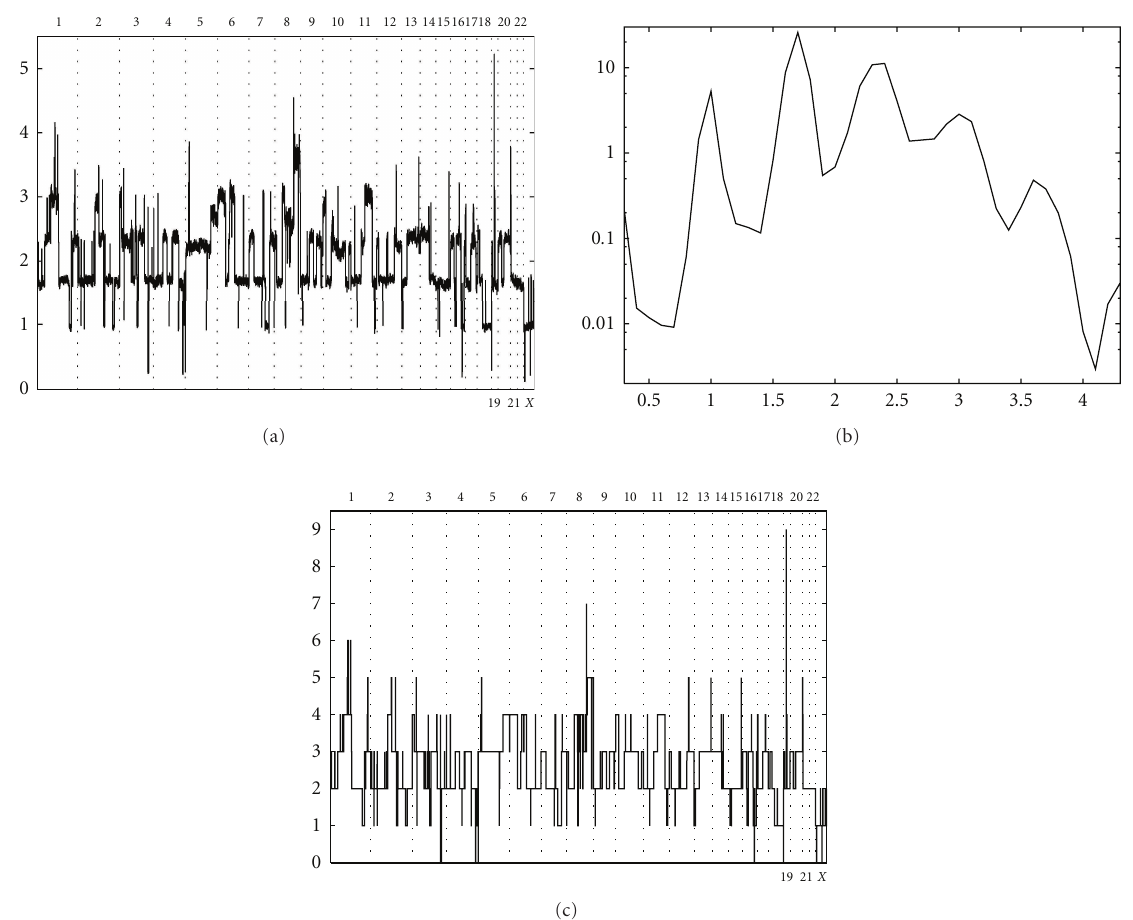
Figure 3: (a) Signal intensity of SNPs ( y axis) for ovarian cancer cell line OVCAR8 before adjustment on genome size. (b) Fraction of SNPs ( x axis) with a certain signal intensity ( y axis) for ovarian cancer cell line OVCAR8 (see (a)). (c) CN solution for ovarian cancer cell line OVCAR8 after adjustment on genome size ( k = 1 . 167).